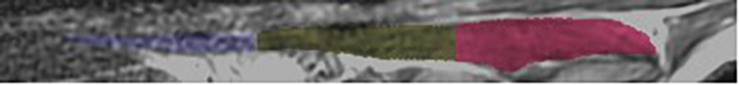
Serratus anterior during rest (top) and contraction (bottom) after the removal of muscle curvature and division into three equidistant sub-regions: anterior (superficial; blue), central (green) and posterior (deep; red).